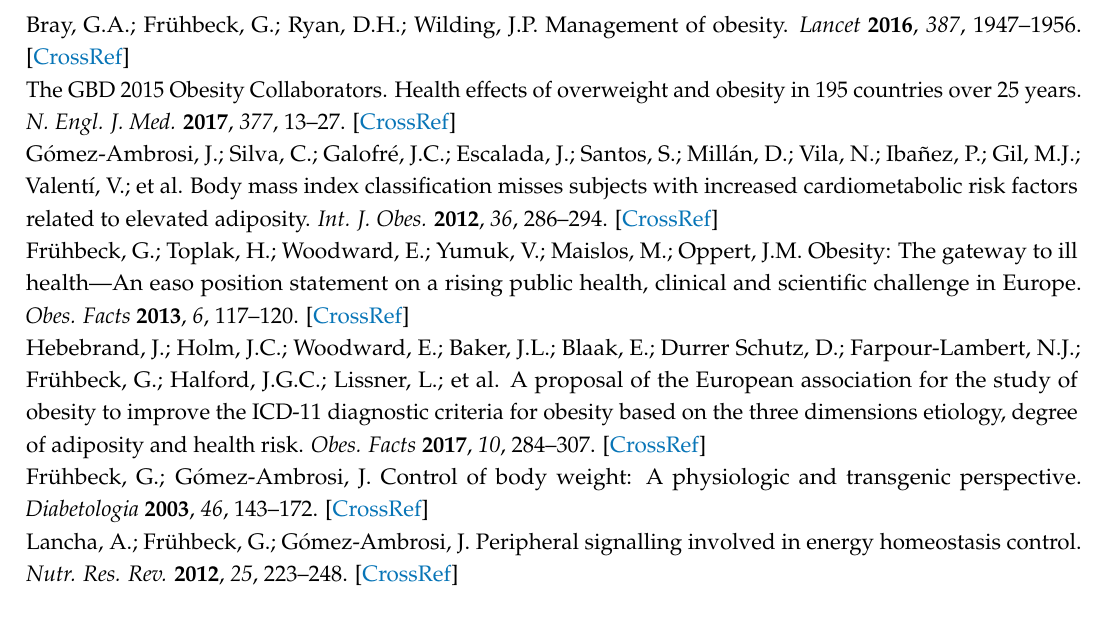
Figure S1: Adpn/Lep ratio according to body adiposity in the 83 lean subjects (low adiposity, n = 42; high SAA n = 41). Statistical differences were analyzed by two-tailed unpaired Student’s t test., Table S1: Analysis of the correlation between several anthropometric and cardiometabolic variables and the markers of adipose tissue dysfunction Adpn/Lep ratio and VAI after adjustment by